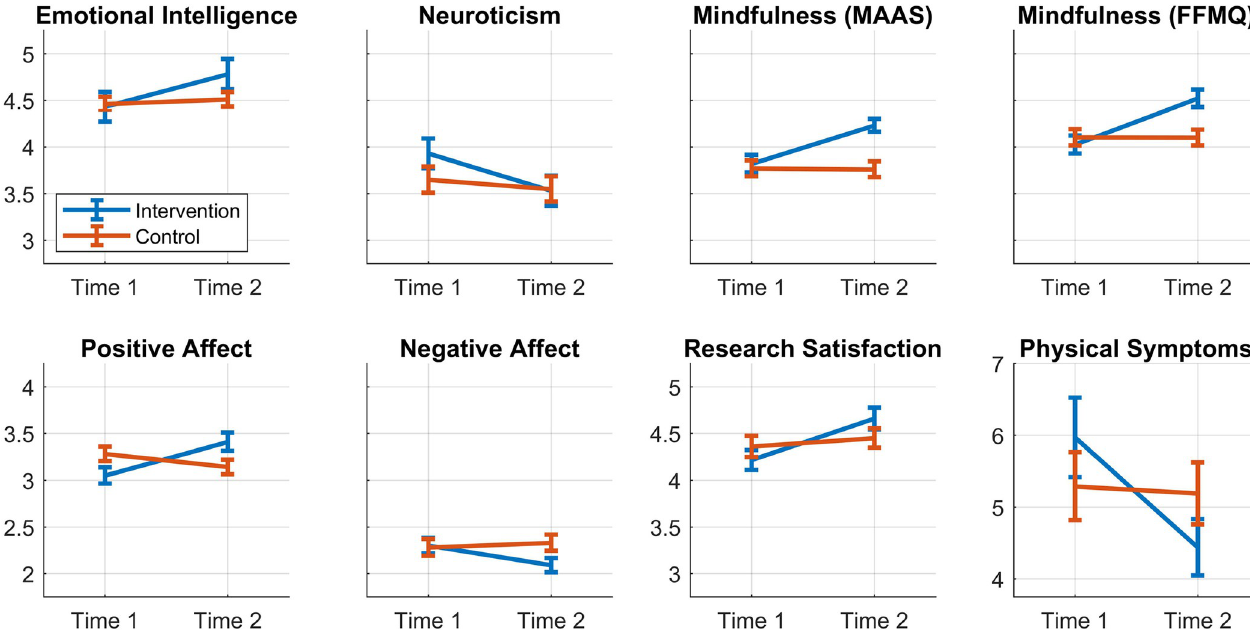
Fig 3. Phase 2 significant effects. Graphical representations of eight significant effects observed between pre- and post-test means for intervention and control groups. The vertical bars represent standard error of the mean. Phase 2 Year 1 and Year 2 are combined.